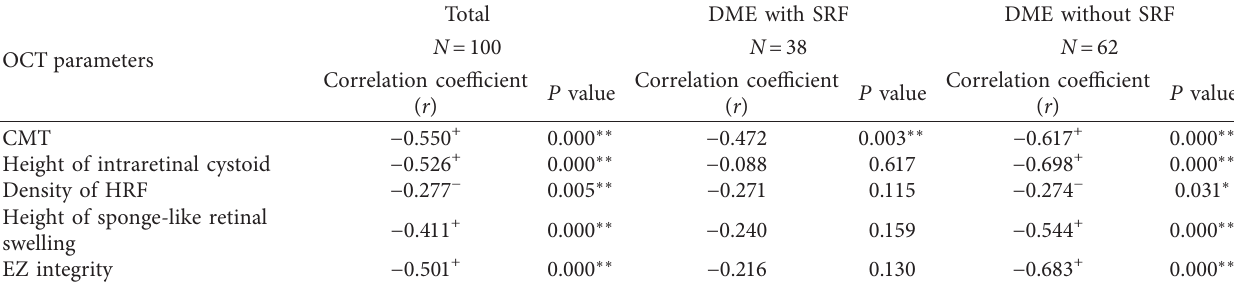
Table 2: Correlation analysis of OCT parameters and BCVA in different